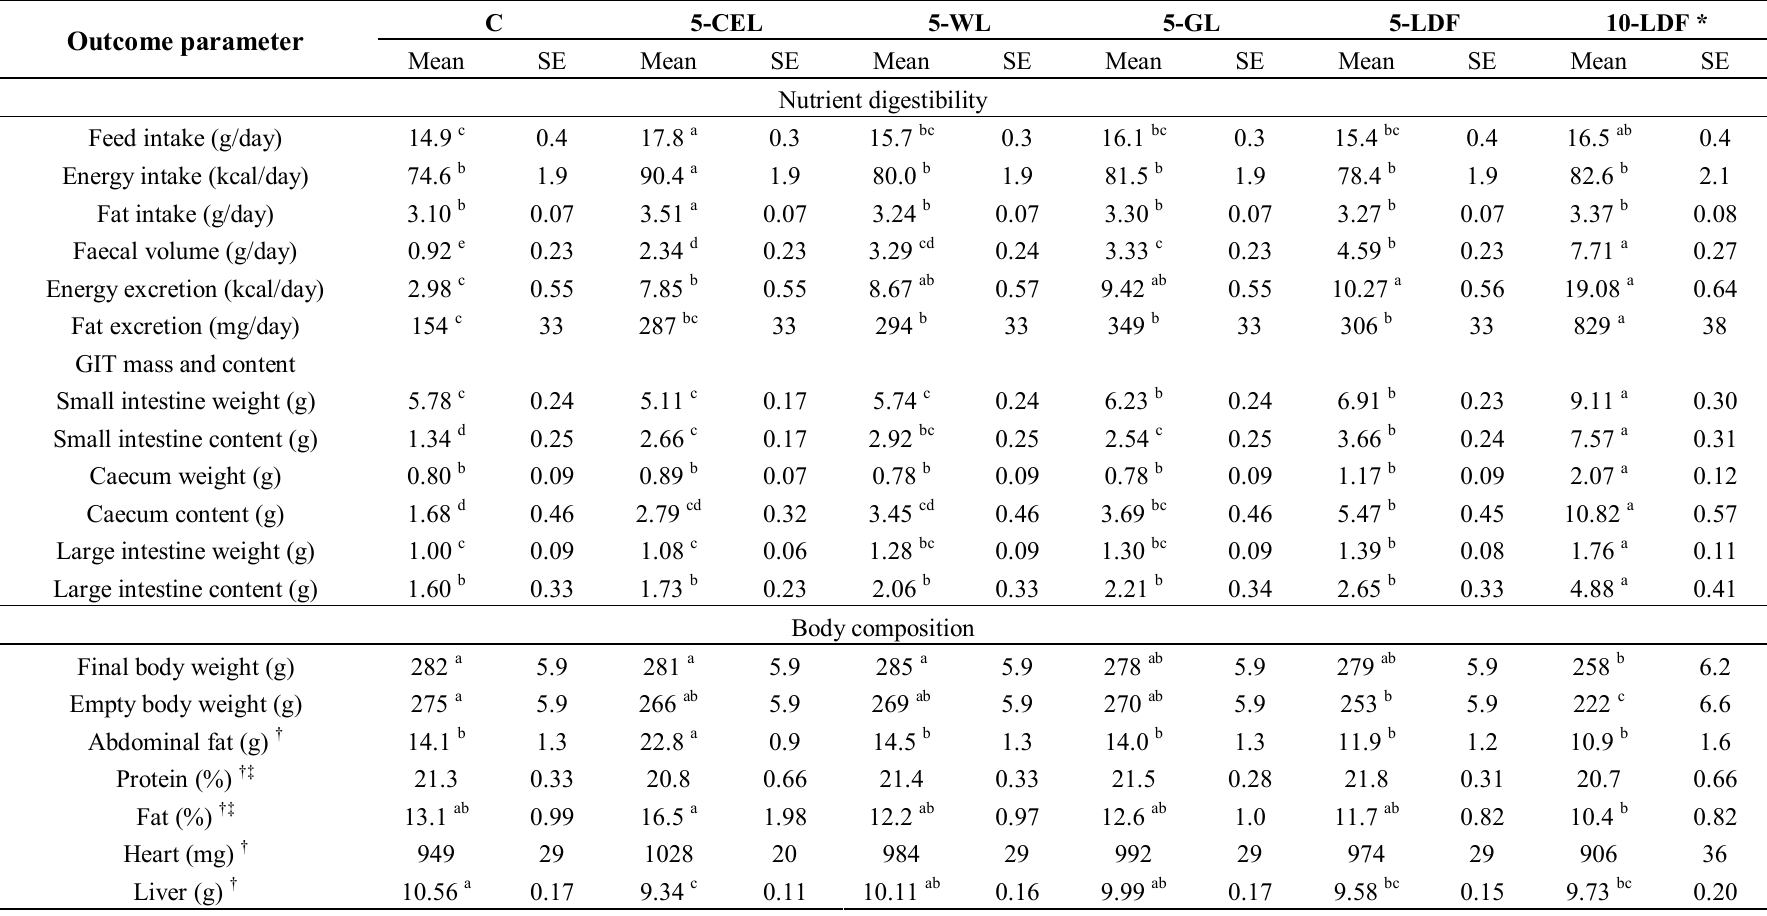
Table 2. Nutrient digestibility, gastrointestinal tract (GIT) mass and content and body composition in rats fed diets with different source and content of DF (Mean ± SE, n =